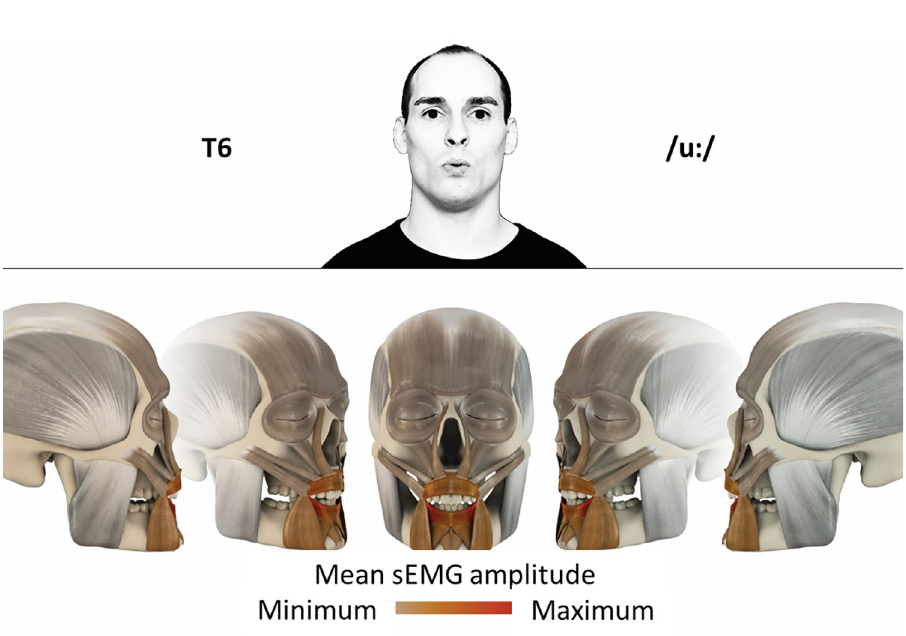
Fig 7. Color-coded facial muscle activation pattern of task T6. Pronouncing the German vowel: U/u ː /. Animation by Jonas Laustro¨er.